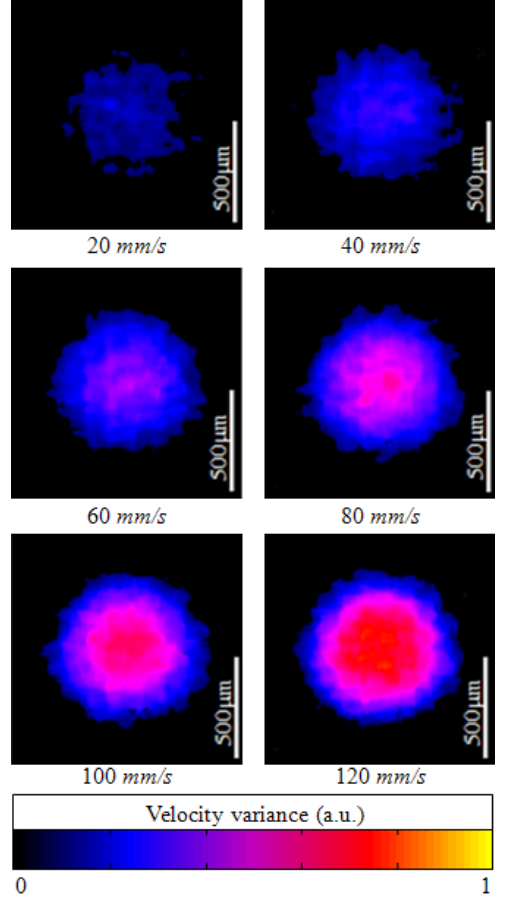
Figure 7. B-scan ODT images of capillary tube with different flow velocities. Doppler angle: 80°. Averaging window size: 12 + 20 ( M + N ).